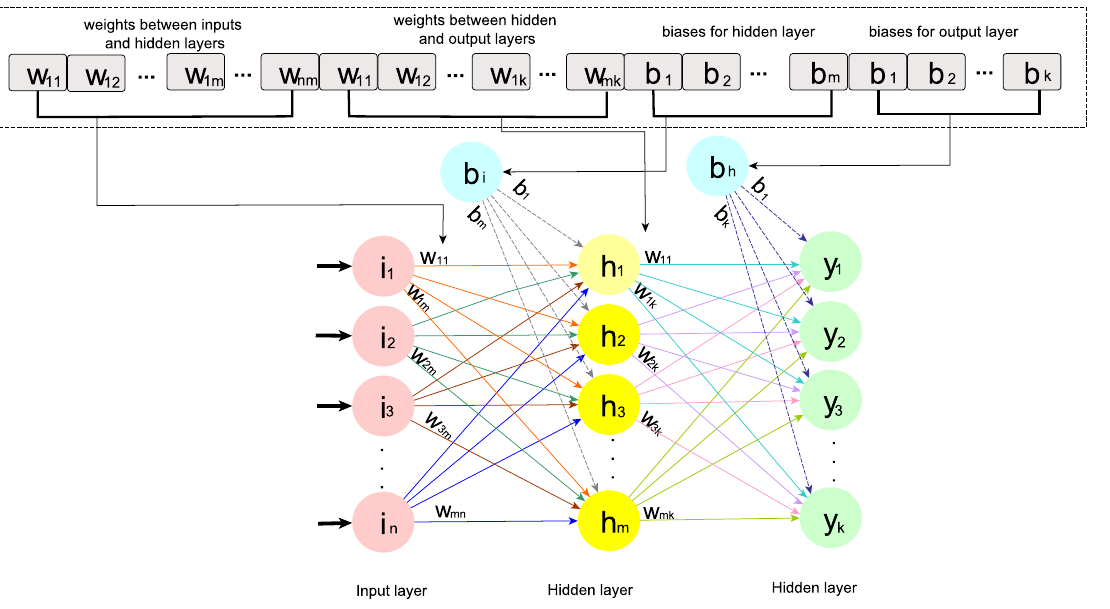
Figure 3. Mapping a GWO individual into MLP network